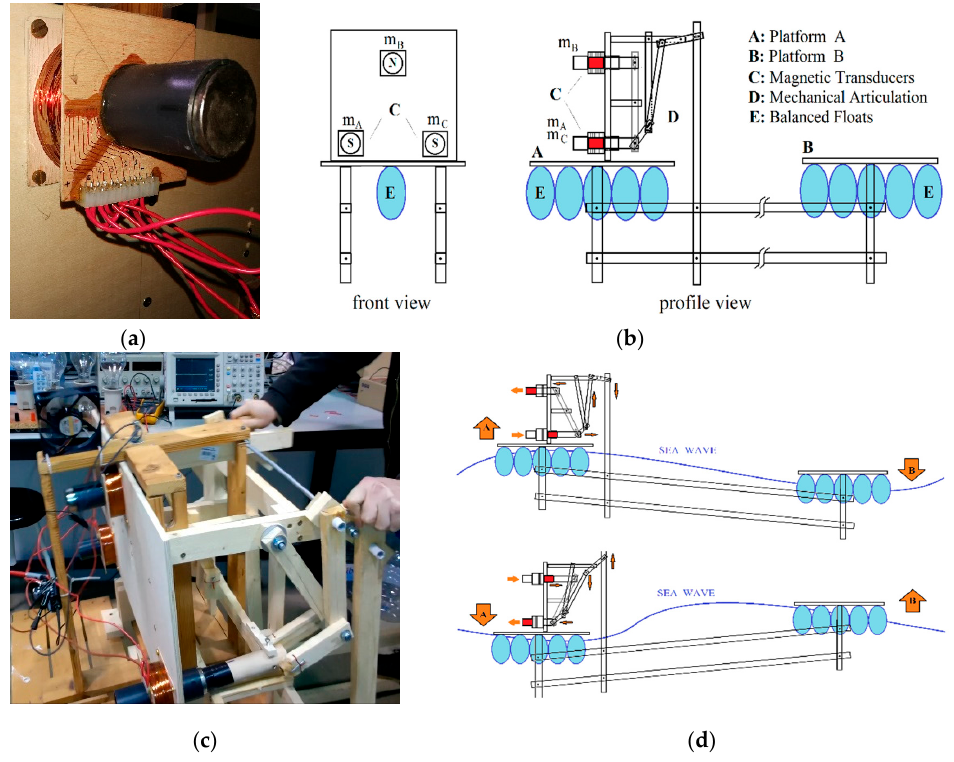
Figure 3. Prototype of a wooden articulated harvesting device made with three transducers: ( a ) detail of a single transducer, ( b ) device scheme: Front and profile views, ( c ) device photograph, and ( d ) operation principle.